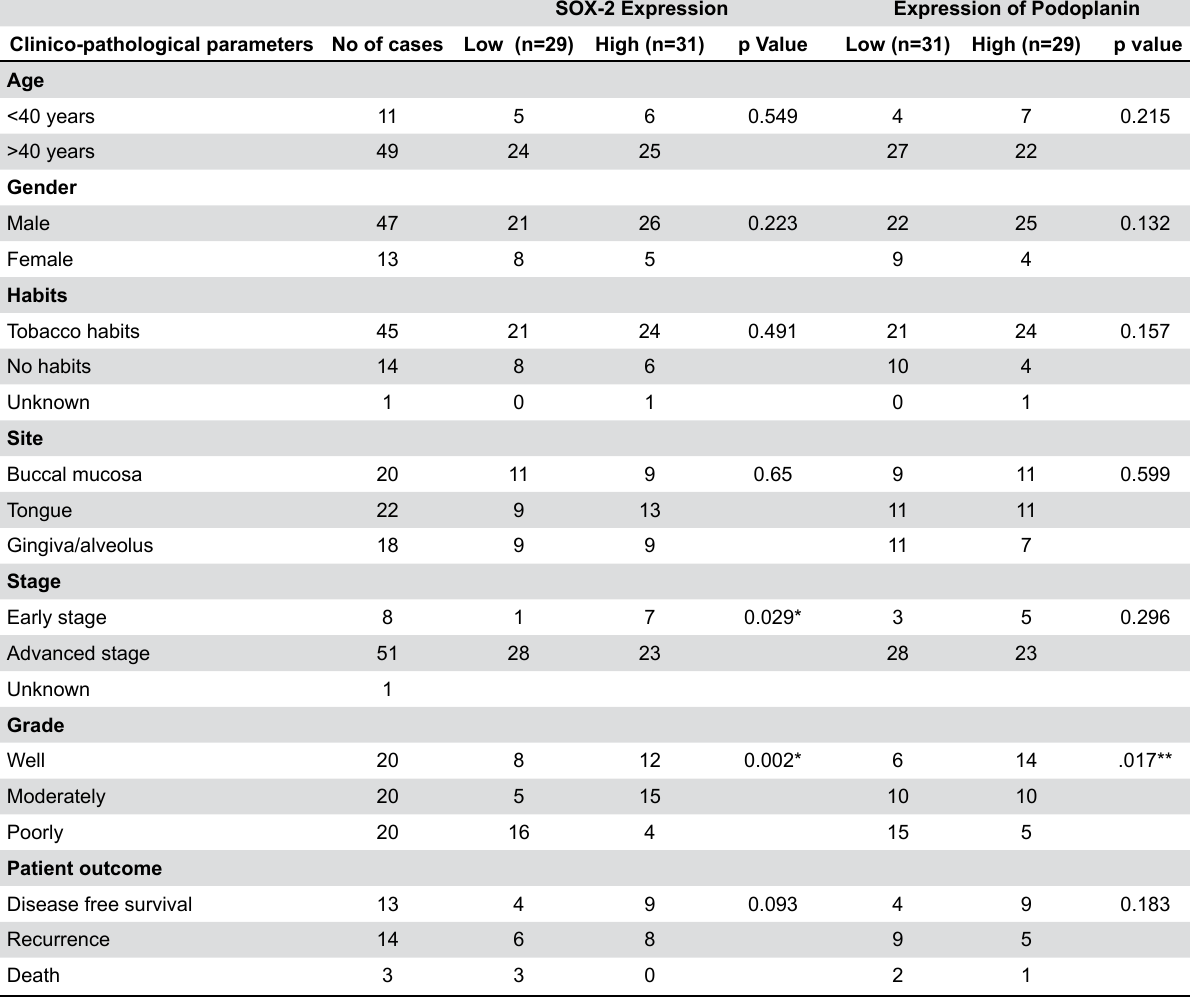
Association of the co-expression of SOX2 and Podoplanin in the progression of oral squamous cell carcinomas - an immunohistochemical Table 1- Association of the expression of SOX2 and podoplanin with clinicopathological features and patient outcomes